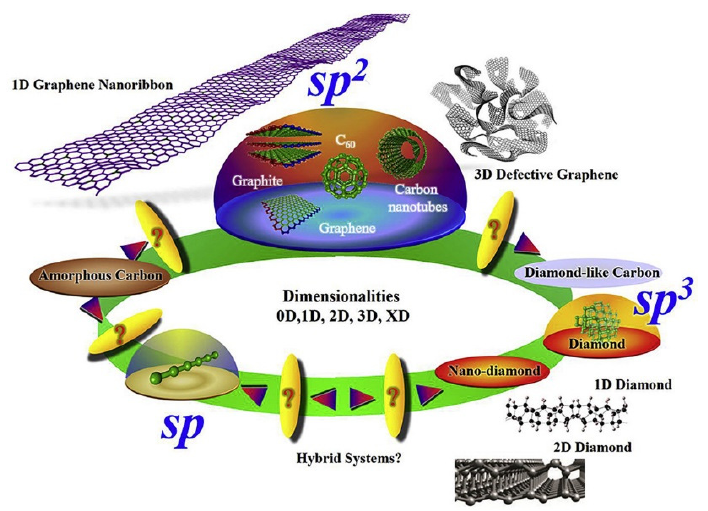
Figure 9. Carbon allotropes with different dimensionalities and hybridizations. Reprinted with permission from Ref. [118]. Copyright © 2023 Elsevier Ltd. All rights reserved.